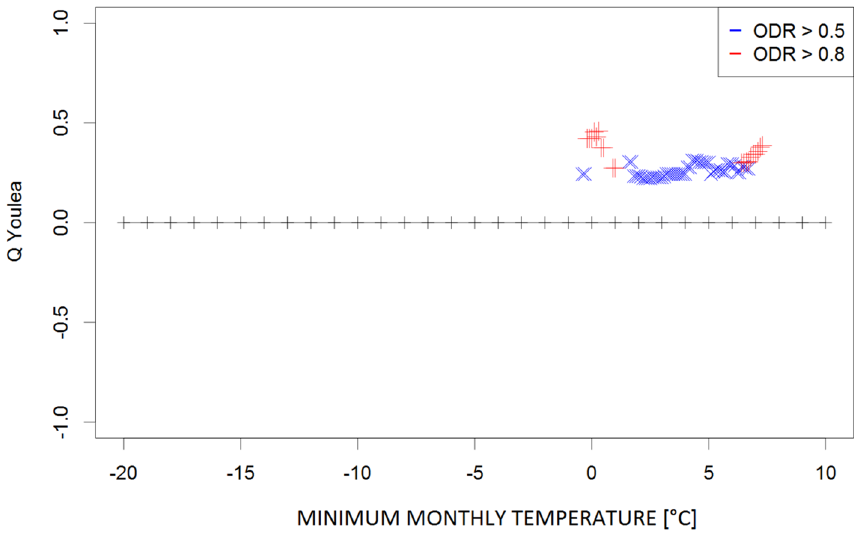
Figure 3. Plot of Q coefficients for different threshold levels of the monthly absolute minimum temperature (Tn_ab) for the investigated ODR limits (≥ 0.5 and ≥ 0.8).